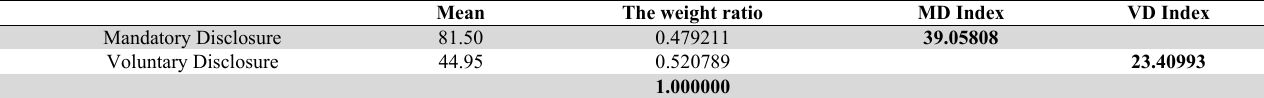
Mean The weight